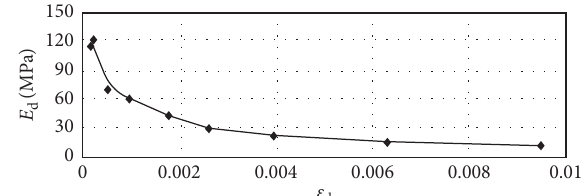
Figure 2: Changes of dynamic elastic modulus with dynamic strain